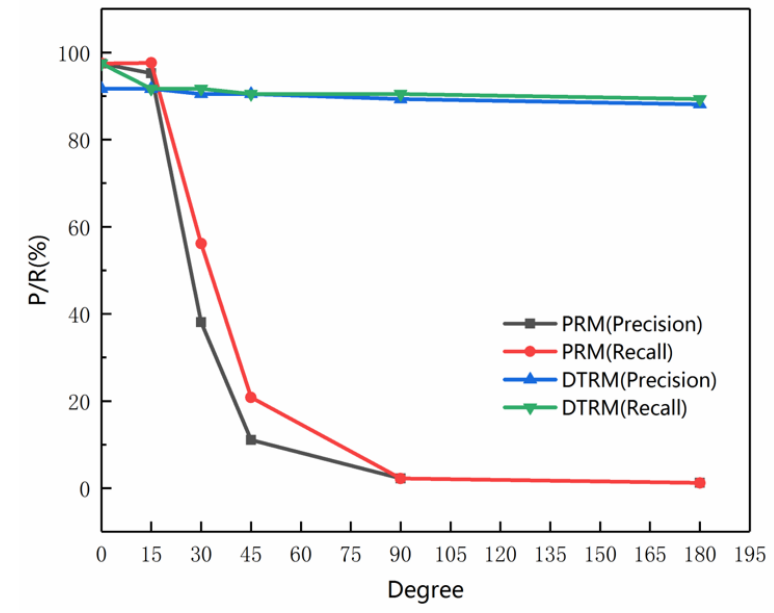
Figure 25. Precision and recall of PRM and DTRM with different rotation angles.